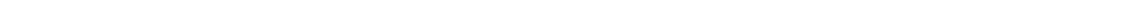
Fig. 2 UNC119 solubilises SFKs in a myristoyl-dependent manner. a , b FRET-FLIM of the interaction between either mCitrine fused to Src a or Fyn b and UNCA-mCh in HeLa cells (see also Supplementary Figs. 3 and 4). For each sample, the fl uorescence intensity of SFK-mCit (donor), the fl uorescence intensity of UNCA-mCh (acceptor), the spatial distribution of the mean fl uorescence lifetime ( τ ) in nanoseconds and the molar fraction of interacting molecules ( α ) are shown per the false-colour look-up tables. The top rows depict the steady-state localisation of wild type (WT) SFK-mCit when co- expressed with UNCA-mCh. The second rows show representative measurements with the polybasic stretch mutant Src 6Q -mCit a or non-palmitoylatable mutant Fyn C3S-C6S -mCit ( b ), and the bottom row shows the non-myristoylatable mutant SFK G2A -mCit proteins when co-expressed with UNCA-mCh. Bar graphs on the right depict average τ ( c , e ) and α -values ( d , f ) for different SFK proteins without ( − ), with UNCA-mCh ( a ), or UNCB-mCh co-expression ( b ; n = 10 – 20 cells/condition, data are mean ± SD from three independent experiments; * P < 0.05; ** P < 0.01; *** P < 0.001; **** P < 0.0001 as determined by one-way analysis of variance (ANOVA) with Bonferroni post – hoc test). For α signi fi cance determination, samples were compared to the donor only control. Cells were sectioned into 10 segments of equal radius from the PM to the centre of the nucleus, and the mean intensity for each channel and α calculated for each segment ( g – j ), for the Src-mCit pro fi le angular masking was performed to look at the pro fi le change across the perinuclear RE compartment. Line diagrams depict the normalised intensity for each channel (SFK-mCit in green and UNCA-mCh in magenta ) and the mean α ( black trace ) in each segment ± SEM; the vertical dotted line indicates the average localisation of the nuclear membrane ( n = 13 cells for Src-mCit, Src 6Q -mCit and Fyn C3S-C6S -mCit, and n = 11 for Fyn-mCit). Scale bars , 10 μ